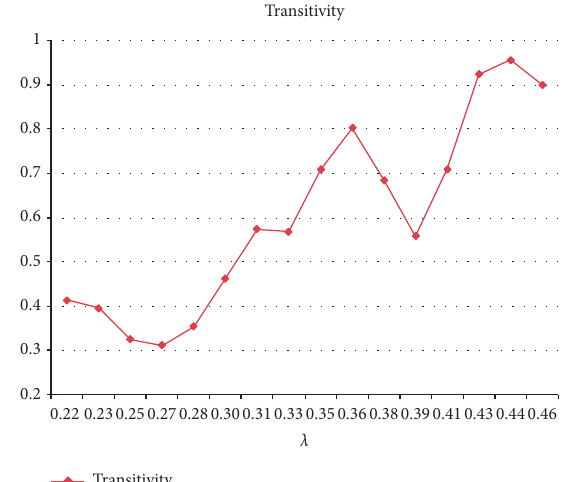
Figure 7: Effect diagram of transitivity change after threshold λ is increased.